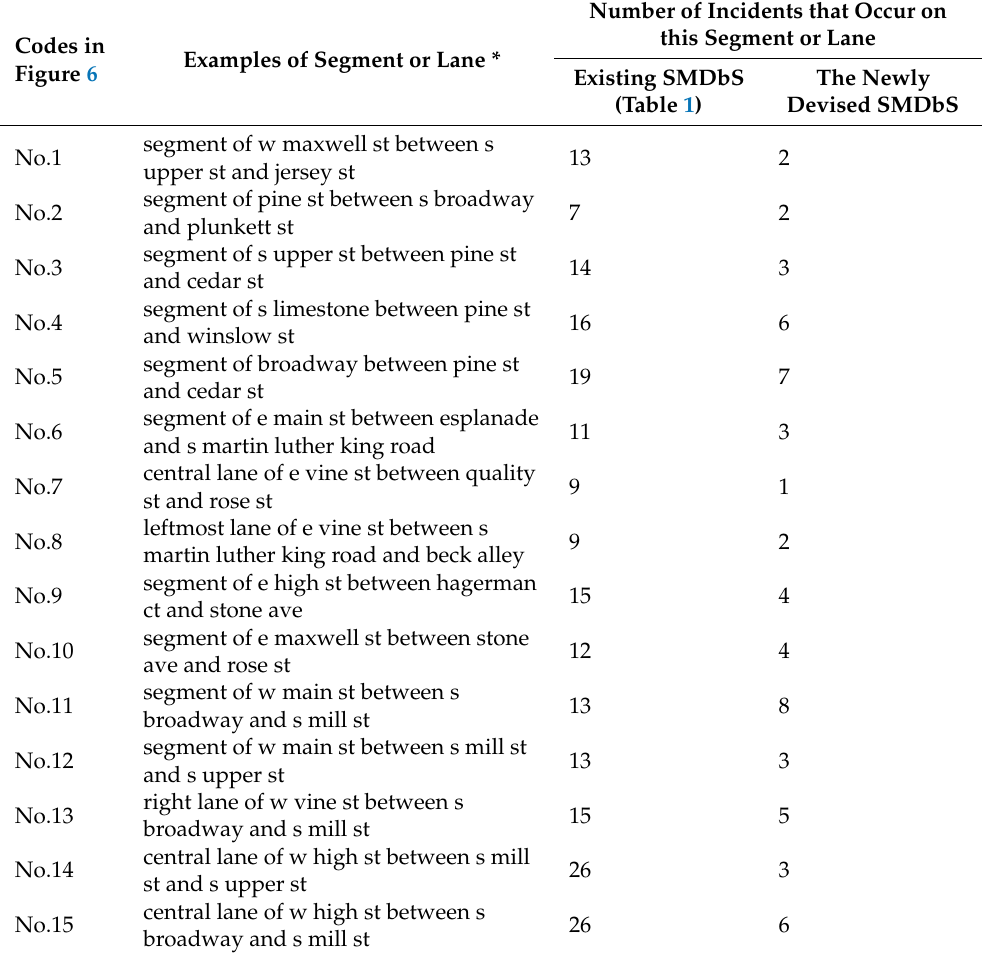
Table 4. Comparison of the number of incidents extracted by the existing SMDbS and the newly devised